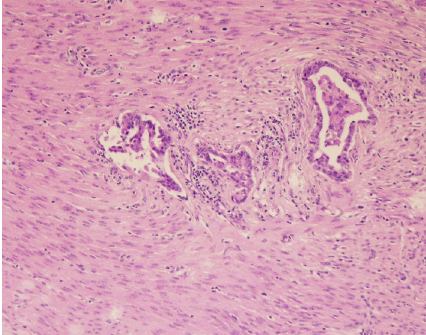
Figure 3: Invasion of lymphatic vessels in the myometrium by cells of the adenocarcinoma (H&E, × 100).